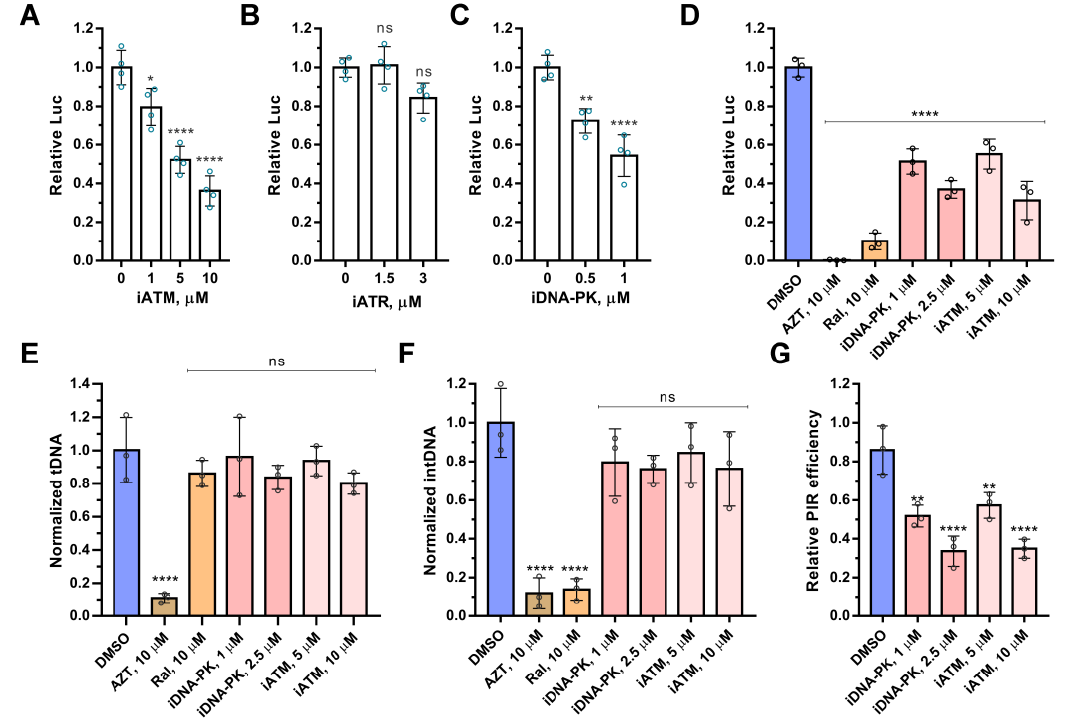
Figure 1. The effect of inhibitors of ATM, ATR, and DNA-PKcs on HIV-1 post-integrational repair. ( A – C ) Analysis of the relative luciferase expression in 293T cells transduced by HIV_wt in presence of increasing concentrations of Ku-55933 (iATM), AZ20 (iATR), and Nu7441 (iDNA-PK). ( D ) The effect of azidothymidine (AZT), raltegravir (Ral), iATM, and iDNA-PK on luciferase expression in 293T cells transduced by HIV_wt. ( E , F ) The level of the total viral DNA ( E ) and integrated viral DNA ( F ) in 293T cells transduced by HIV_wt in presence of AZT, Ral, iATM, and iDNA-PK. ( G ) Efficiency of post-integrational DNA repair in 293T cells transduced by HIV_wt in presence of iATM or iDNA-PK. Mean values ± SD of three ( D – G ) or four ( A – C ) independent experiments are presented. Significance was determined by one-way ANOVA with Dunnett’s correction for multiple comparisons, ns—not significant, * = adj. p -value < 0.05, ** = adj. p -value < 0.01, **** = adj. p -value < 0.0001.